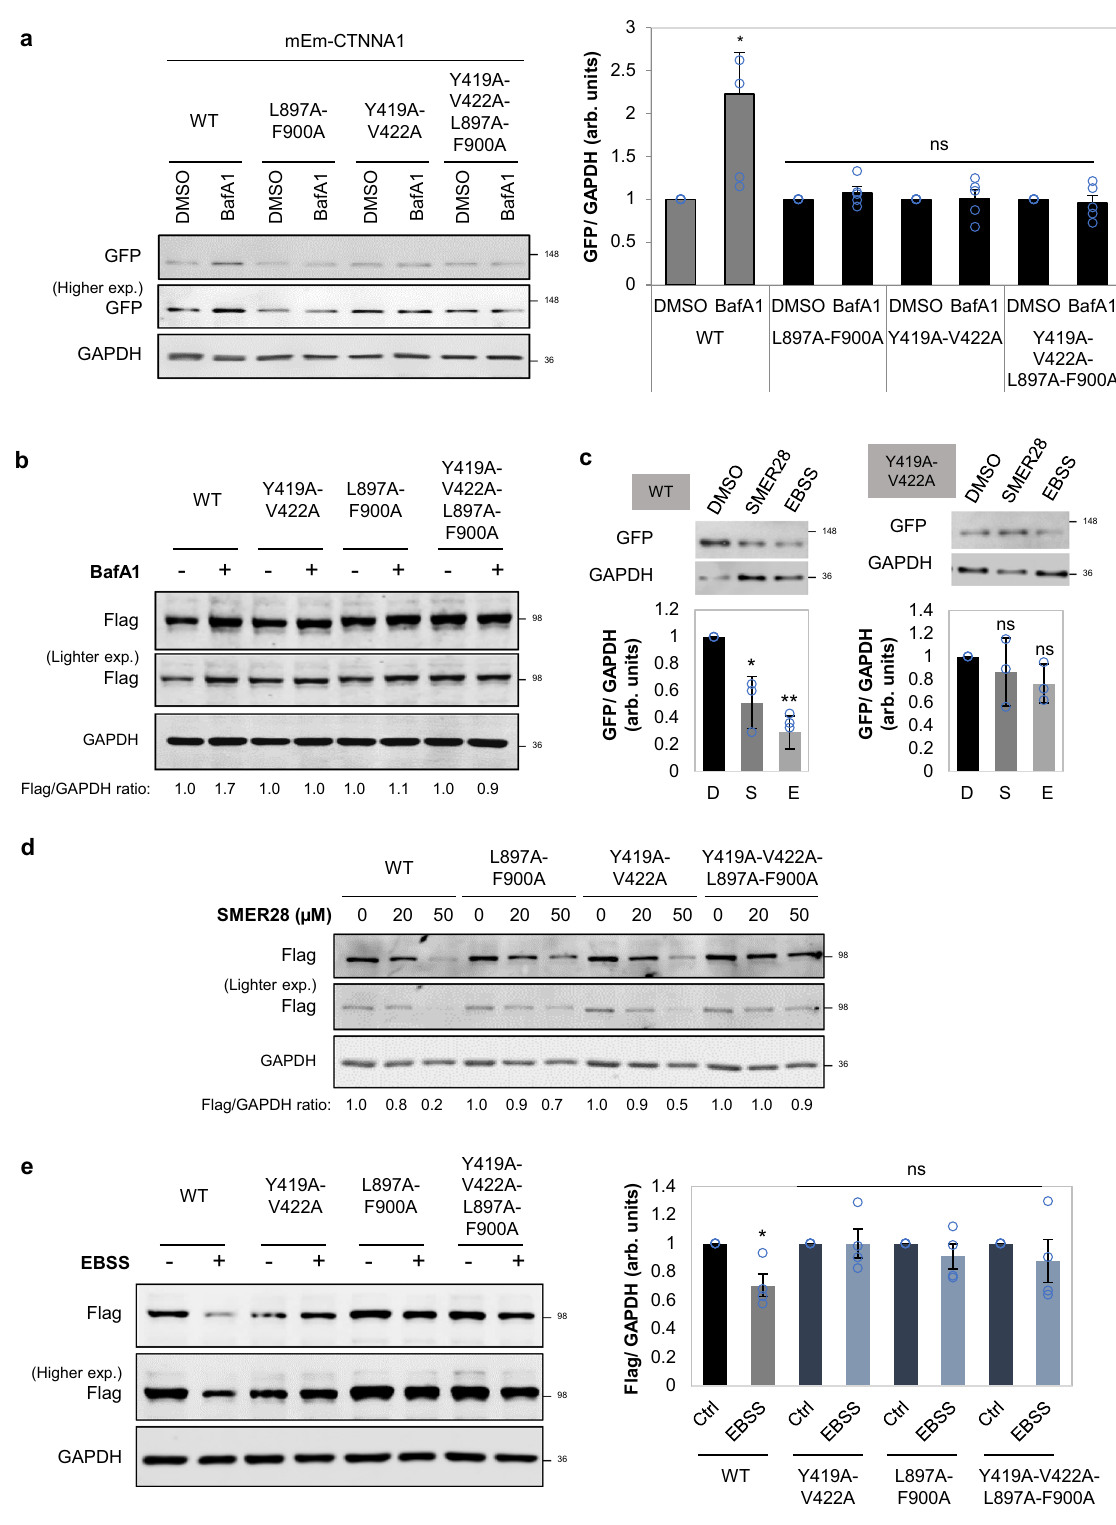
(no. 8505, Cell signalling, WB 1:1000), normal rabbit IgG (no. 2729S, Cell Sig- CTNNA3 (ab184916, WB 1:1000) from Abcam. Mouse monoclonal anti-LC3 nalling), rabbit polyclonal anti-ATG16L1 (no. 8089, Cell Signalling, IF 1:200), (clone 5F10, Nanotools, IF 1:200), mouse monoclonal anti-YAP/TAZ (63.7) (sc- rabbit anti-ATG16L1 (PM040, MBL, WB 1:1000), mouse anti-Flag M2 (F3165, 101199, Santa Cruz Biotechnology, IF 1:100), goat polyclonal anti-LaminB (M-20) Sigma-Aldrich, WB: 1:2000). (sc-6217, Santa Cruz Biotechnology, WB 1:100), mouse monoclonal anti-LAMP1 The secondary antibodies used for IF were conjugated to Alexa Fluor 488, 568, (ab25630, IF: 1:100), rabbit monoclonal anti-S6 Ribosomal Protein (5G10) (no. 594 or 647 (Invitrogen). The horseradish peroxidase-conjugated secondary 2217, Cell Signalling, WB 1:1000), rabbit monoclonal anti- α -E-catenin (anti- antibodies used for western blotting were as follows: anti-mouse (NA931V, GE CTNNA1) (no. 3236, Cell Signalling, WB 1:1000), rabbit monoclonal anti-MLC2 NATURE COMMUNICATIONS| (2021) 12:1703